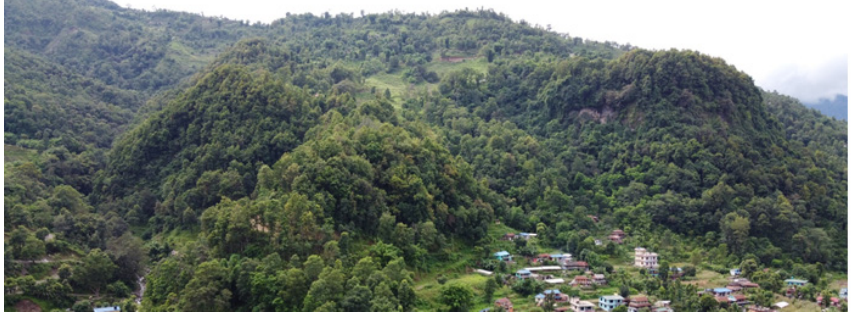
Figure 6. Typical mountain forests with overstocked and underutilized conditions: externally induced institutions have constrained the local community to manage and use the forest resources with indigenous practices for food security and livelihoods.